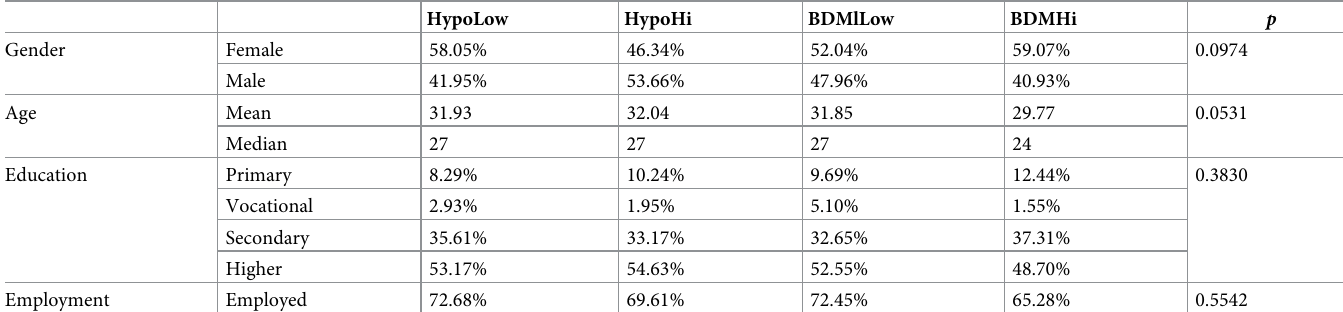
Table 11. Experiment 3: Comparison of characteristics of respondents in all treatments.